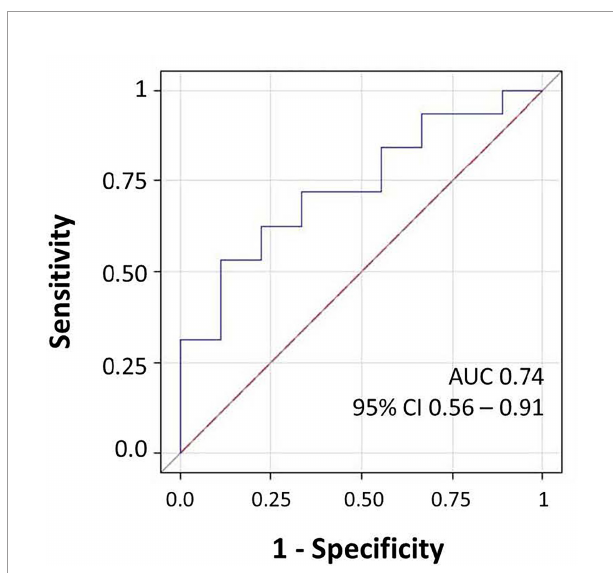
FIGURE 3 | Receiver operating characteristic (ROC) curve for microbiome score for prediction of the presence of IgG at follow-up. The area under the ROC curve (AUC) and 95% CI values were